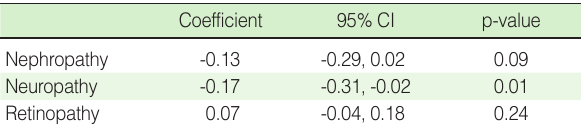
Table 5. Multiple linear regression for the sum scale score of